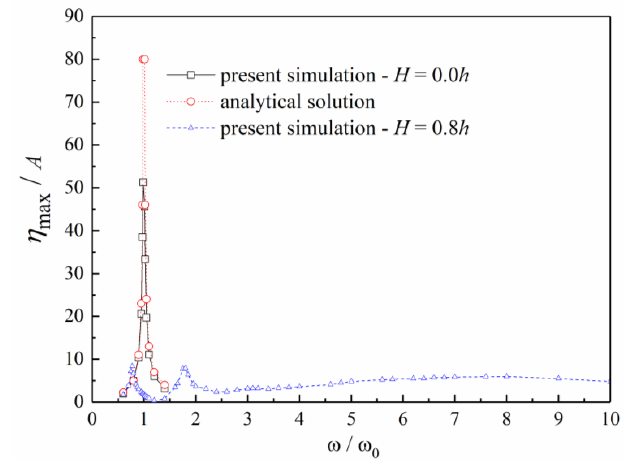
Figure 15. The maximum free surface elevation at y = 0 of sloshing in a tank without (results of the present simulation and analytical solution of Faltinsen [34]) or with (results of the present simulation) a vertical baffle under different excitation frequencies.